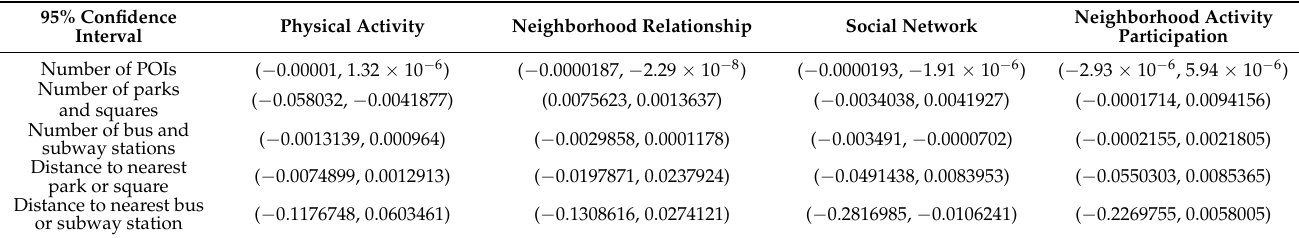
Table 5. Results of the bootstrap